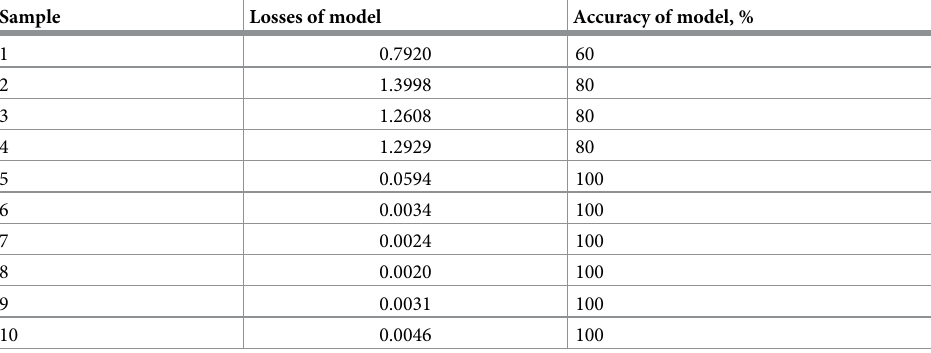
Table 3. Results of k-Fold